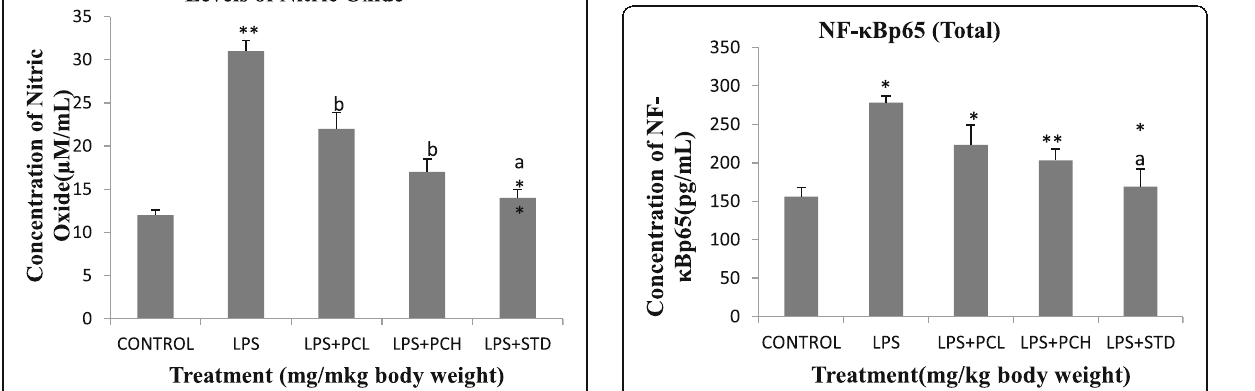
Fig. 2 Graphical Representation of levels of NF- κ Bp65 (Total) in Liver tissues of male Swiss albino mice. STD- Standard dose; PCL – Prosopis cineraria low dose; PCH- Prosopis cineraria high dose. Values are represented as mean ± SD (n = 6). *p < 0.05, **p < 0.001 v/s control group (C);ap < 0.05, bp < 0.001 v/s LPS treated group